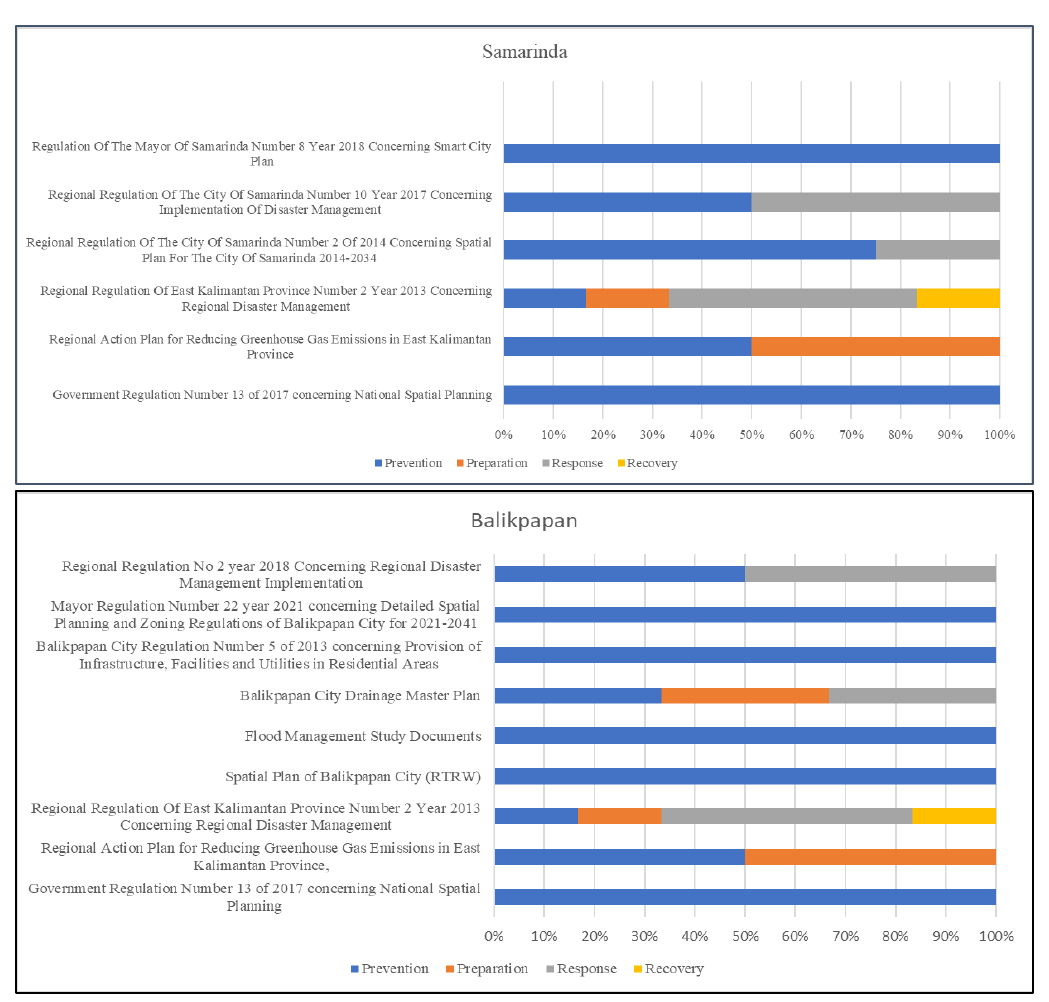
Figure 5. Distribution of flood resilience strategies in the selected local government documents in Samarinda and Balikpapan .